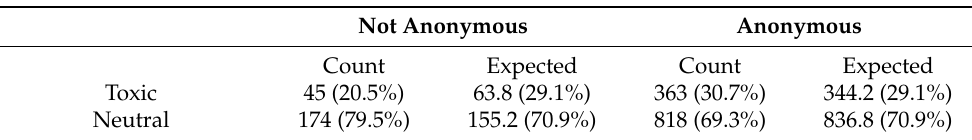
Table 1. The count and expected count of anonymous and non-anonymous comments that were coded as toxic and neutral